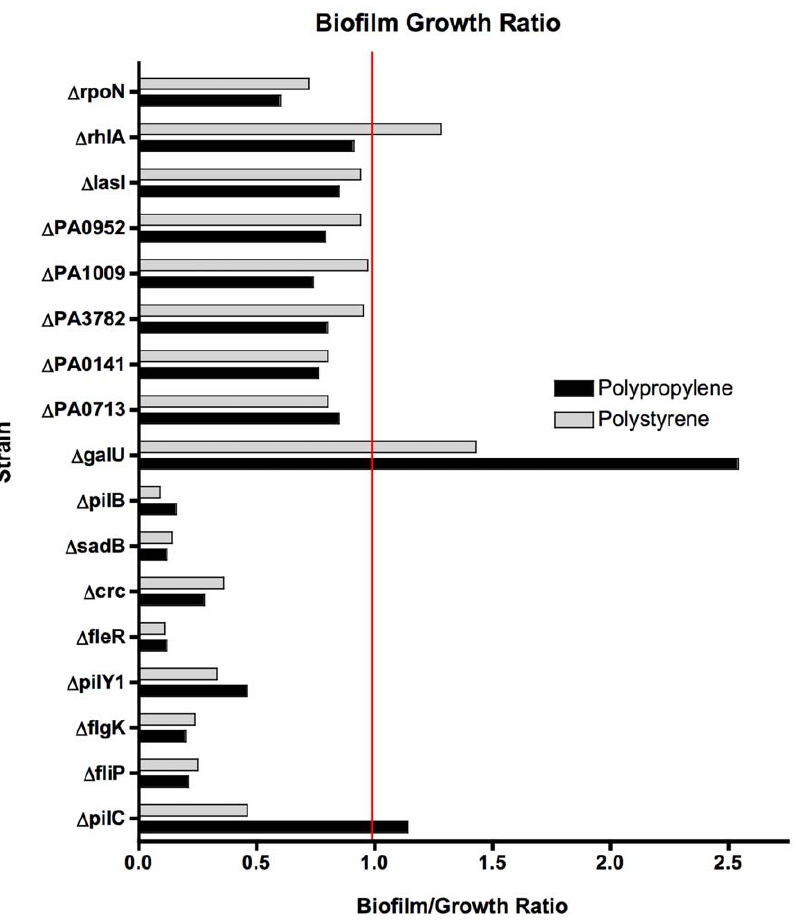
Figure 3. Biofilm/Growth Ratios for P.aeruginosa PA14 transposon-insertion mutants listed above. Bars represent the means for three separate biological replicates (each biological replicate is the mean of seven technical replicates). Ratios , 1 indicate decreased biofilm formation relative to growth level. By definition WT biofilm/growth ratio is 1, as biofilm and growth levels were used to calculate the ratio are in % of WT. The red line indicates biofilm growth ratio of